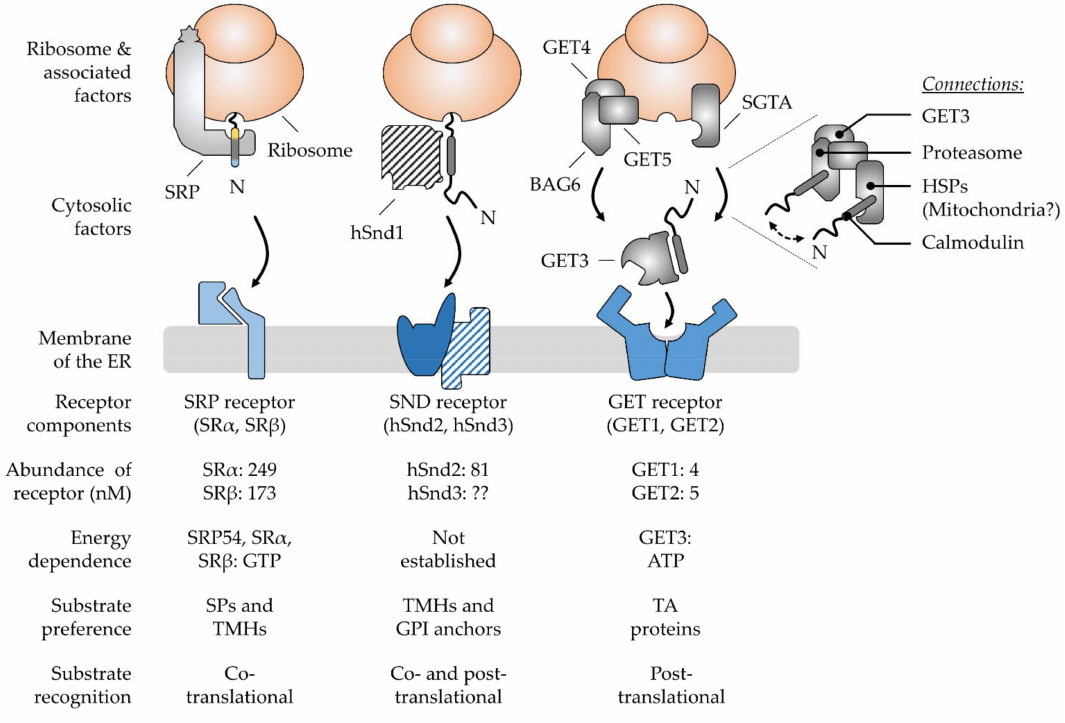
Figure 3. Major components and hallmarks of the mammalian SRP, SND, and GET targeting path- ways. The top half shows a graphical output of the major components that shape the three